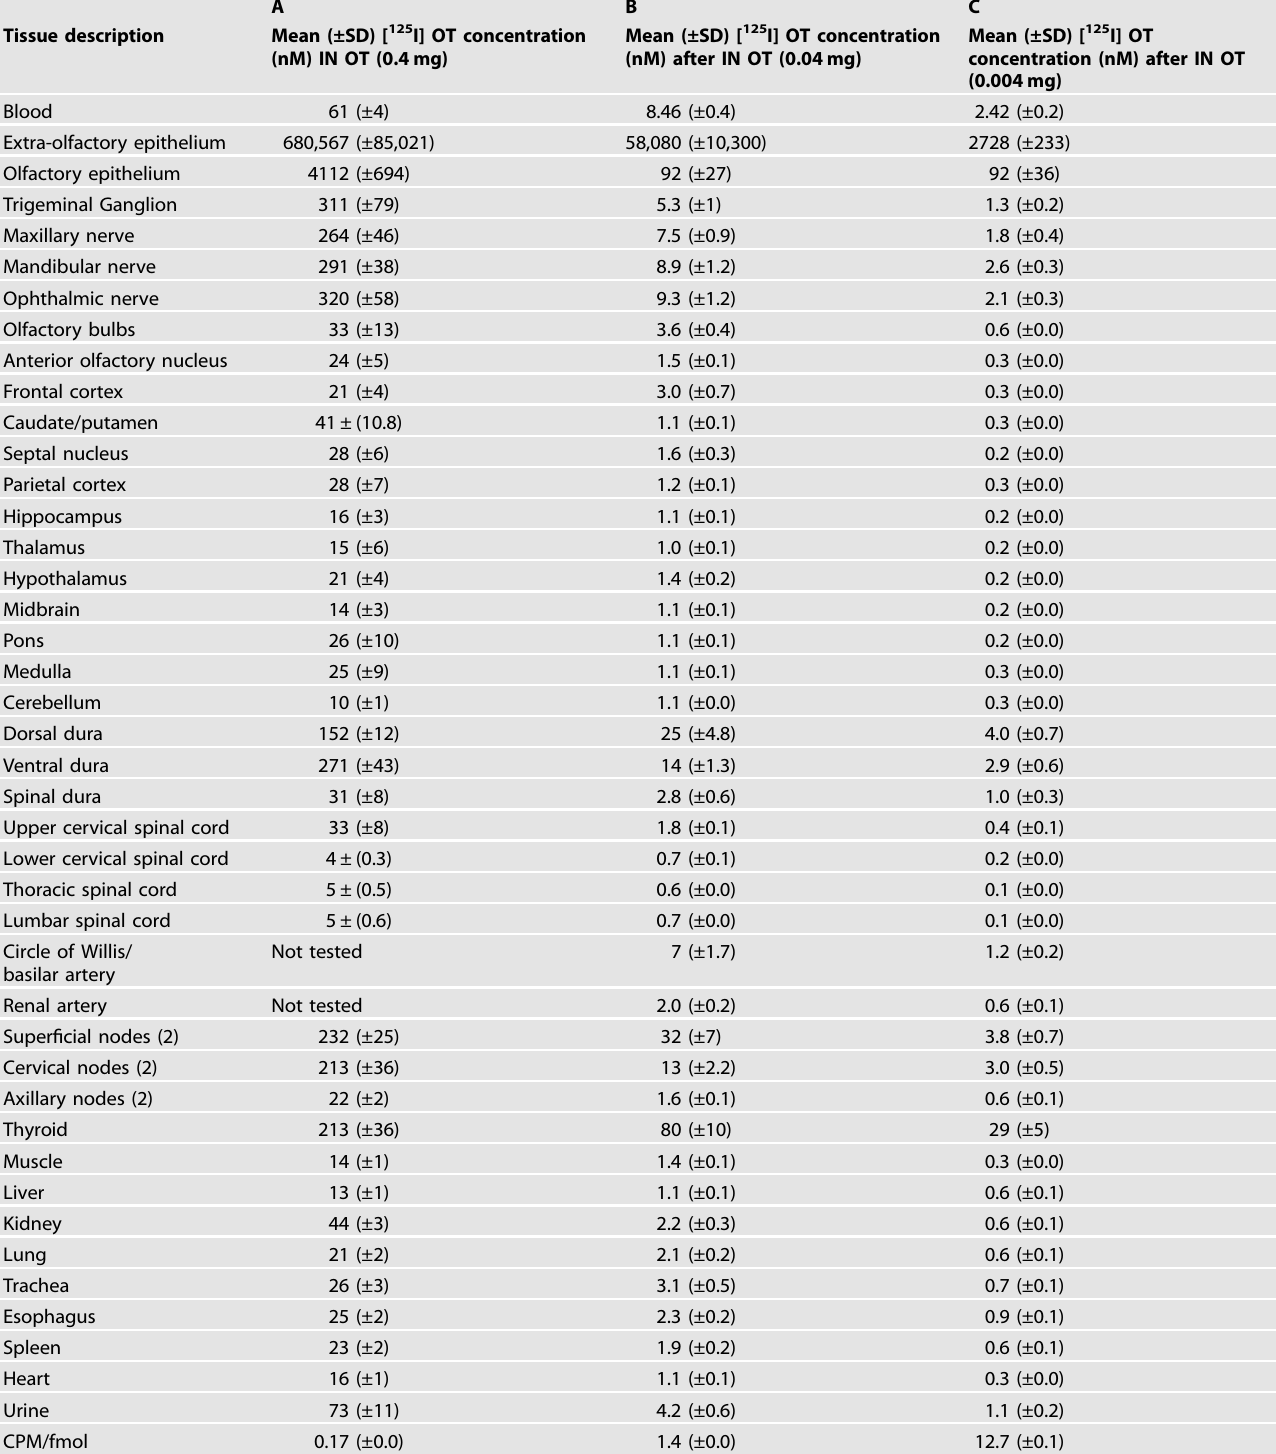
Table 2. Gamma counts representing [125I] oxytocin (OT) concentration 30 min after: (A) 0.4 mg, (B) 0.04 mg, and (C)0.004mg [I125] OT intranasal administration. A